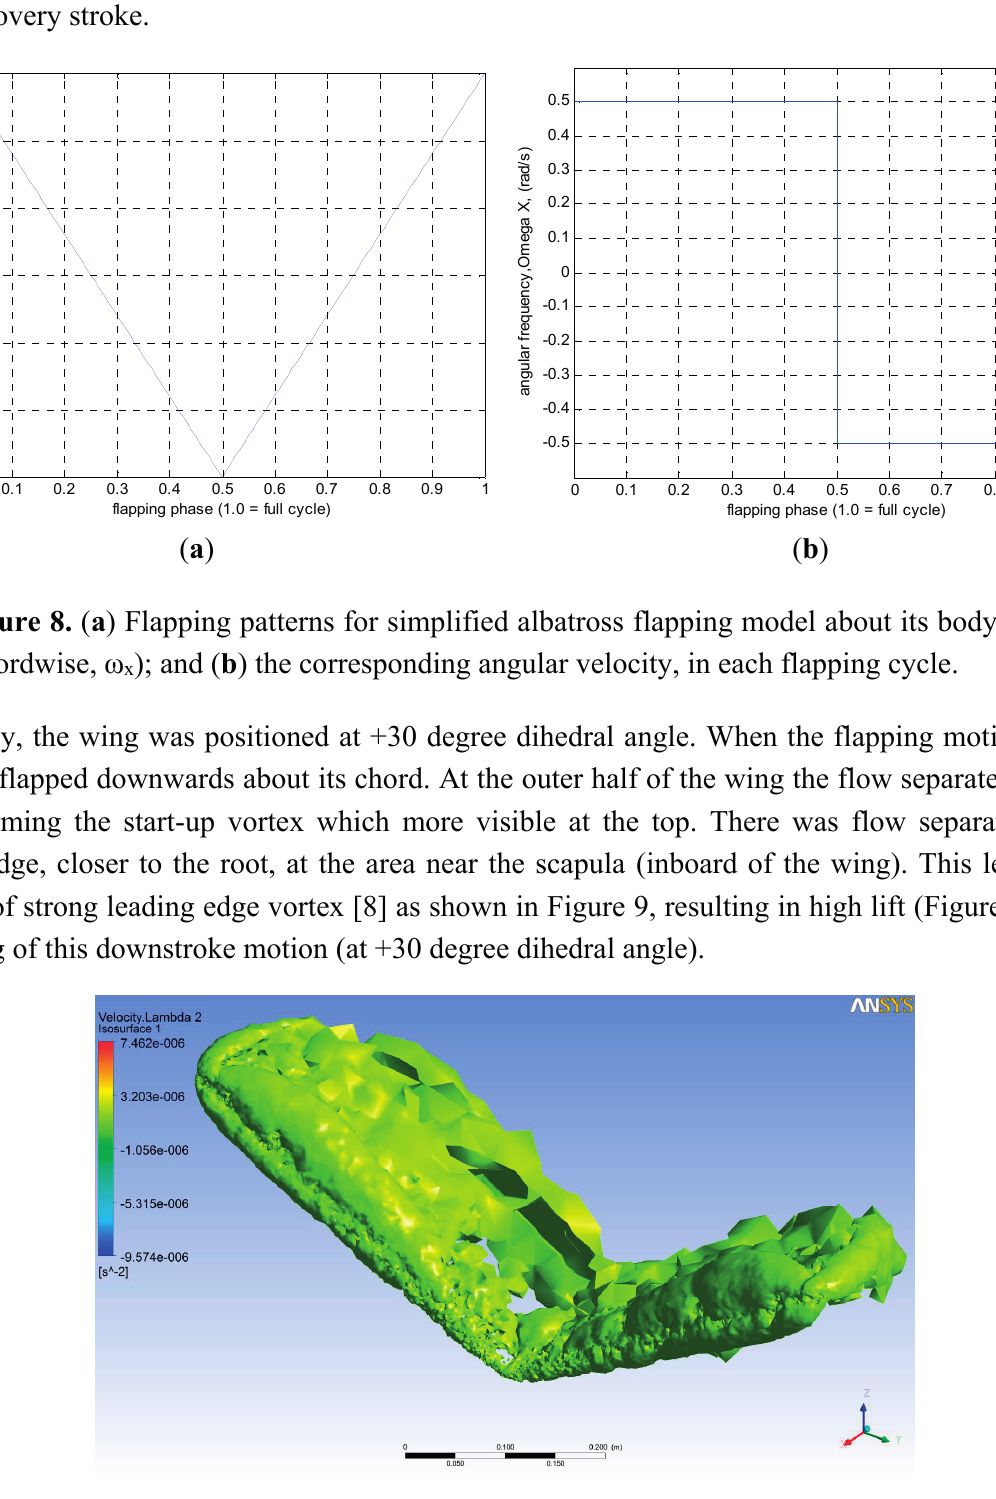
Figure 9. Vortex structure on the wing, shortly after start-up. The strong leading edge vortex on the upper part is clearly